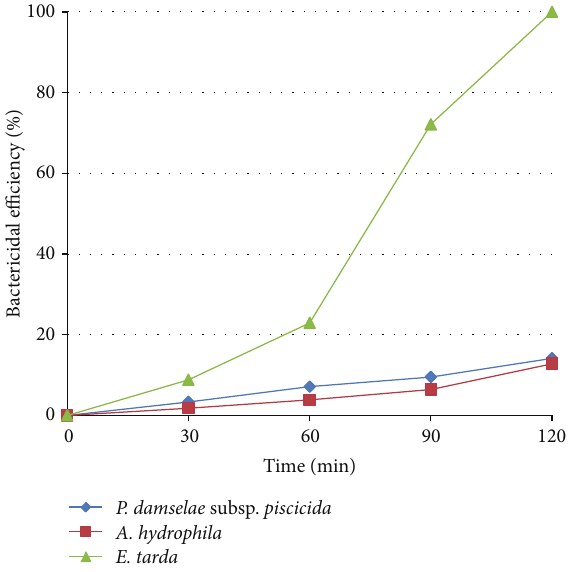
Figure 13: Bactericidal efficiency of 2.7 mg Ag-TiO 2 /Fe 3 O 4 to Aeromonas hydrophila ( ◼ ), Edwardsiella tarda ( 󳵳 ), and Photobac- terium damselae subsp . piscicida ( ⧫ ) in the